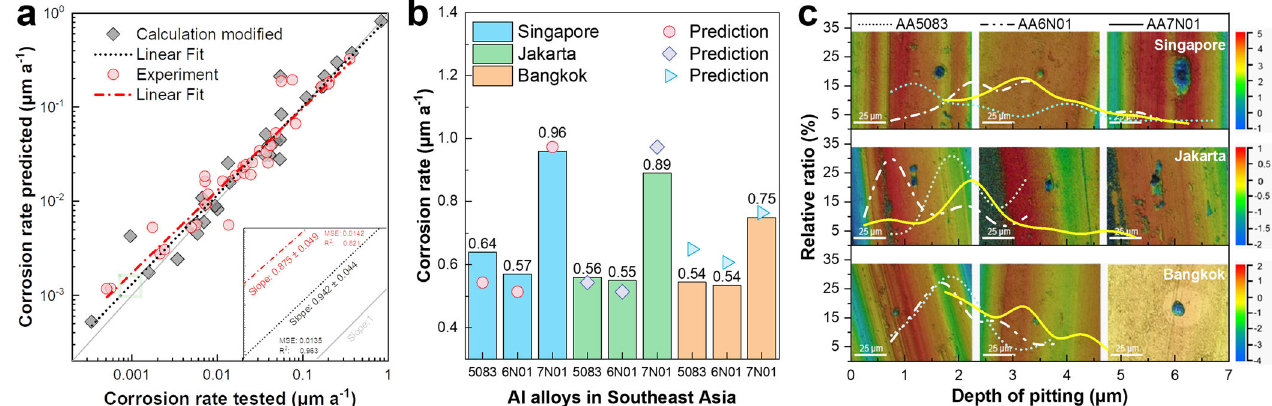
Fig. 8 Independent veri fi cation of two feasible models for Al alloys fi eld exposure data. a Comparison of RF models trained by the pure experimental corrosion dataset or ab-initio calculation modi fi ed dataset. b Three different Al alloys, AA5083, AA6N01, and AA7N01, were placed in Southeast Asia (Singapore, Jakarta, and Bangkok) for 2 years to examine the generalization ability of the RF model with phase calculation. c Corrosion morphology and statistics on the number and depth of pits in Al alloys after fi eld